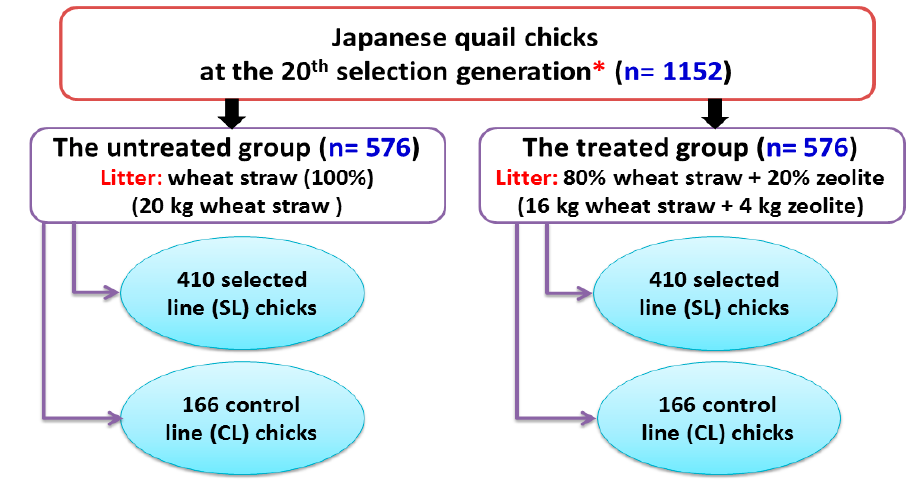
Figure 1. Experimental design .